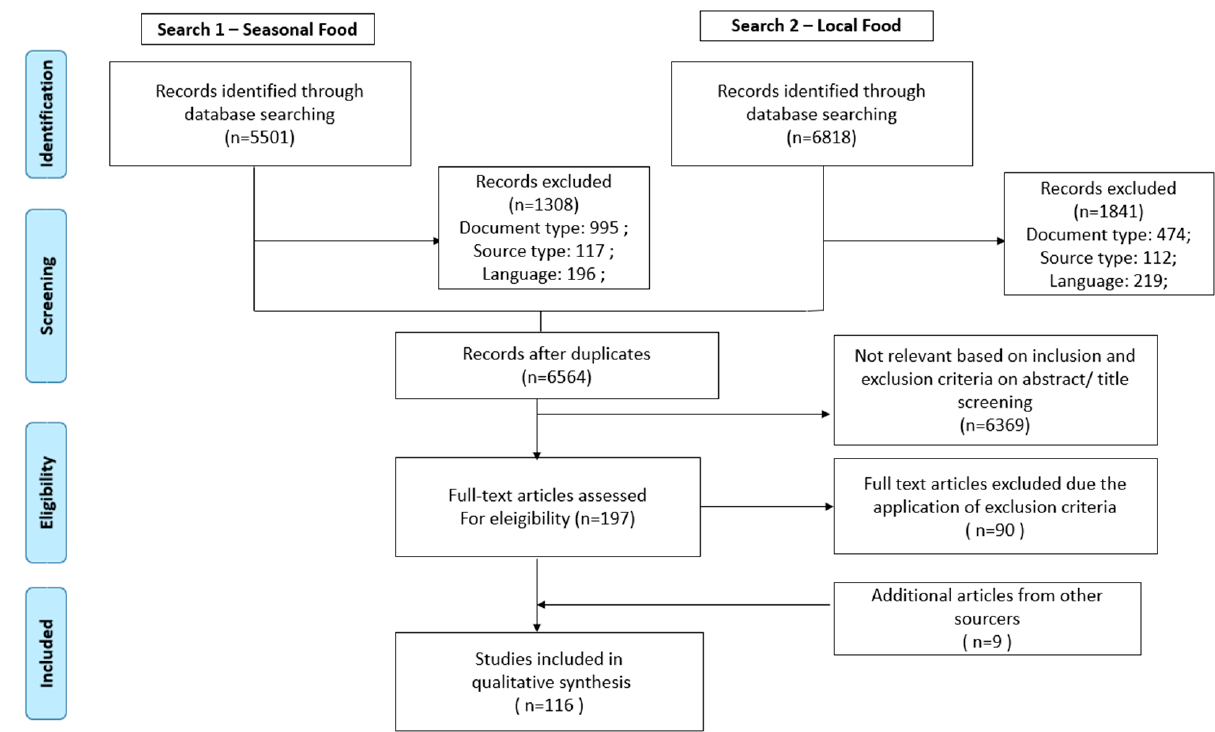
Figure 1. PRISMA flow diagram of the study selection. Adapted from Page et al. [23].